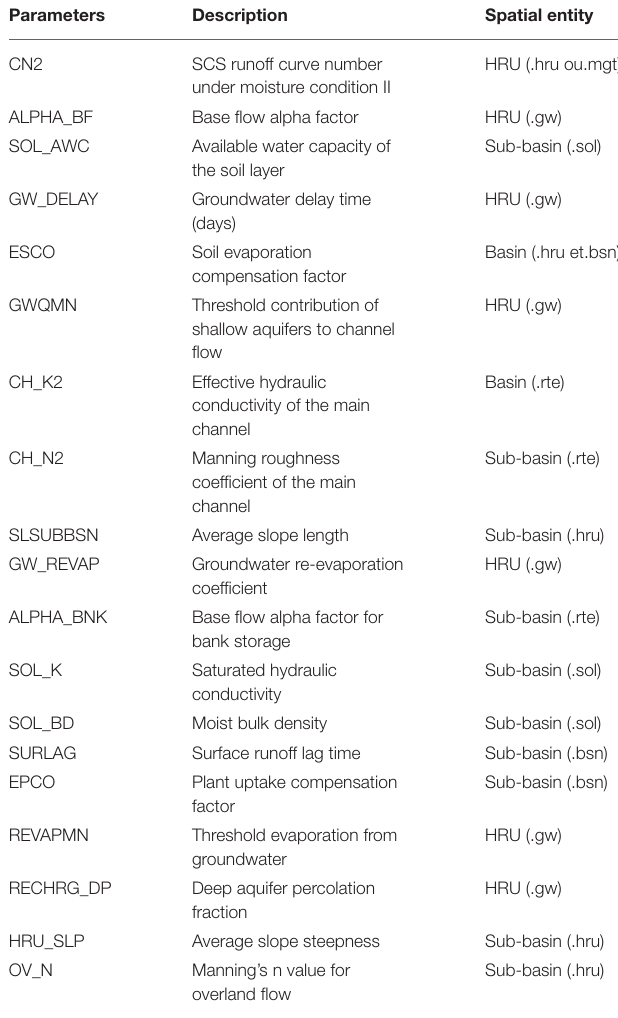
TABLE 1 | List of parameters analyzed with the SUFI-2 algorithm.